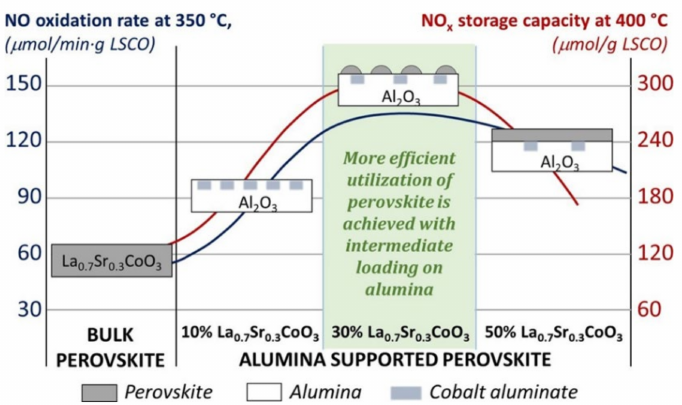
Figure 4. NO oxidation rate and NO x storage capacity as functions of the loading of La 0.7 Sr 0.3 CoO 3